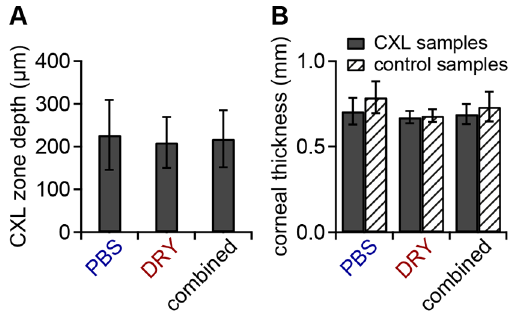
Figure 4. Depth of the CXL zone and corneal thickness. Pachymetry readings were executed centrally on every sectioned specimen using the optical unit of the atomic force microscope. A ) Mean stromal depth of the CXL zone for the PBS group, the DRY group, and the combined groups. B ) Mean corneal thickness at the location of the profile measurement for the PBS group, the DRY group, and the combined groups. No significant difference in corneal thickness was found with respect to preparation type or cross-linking status. Error bars indicate the standard deviation.